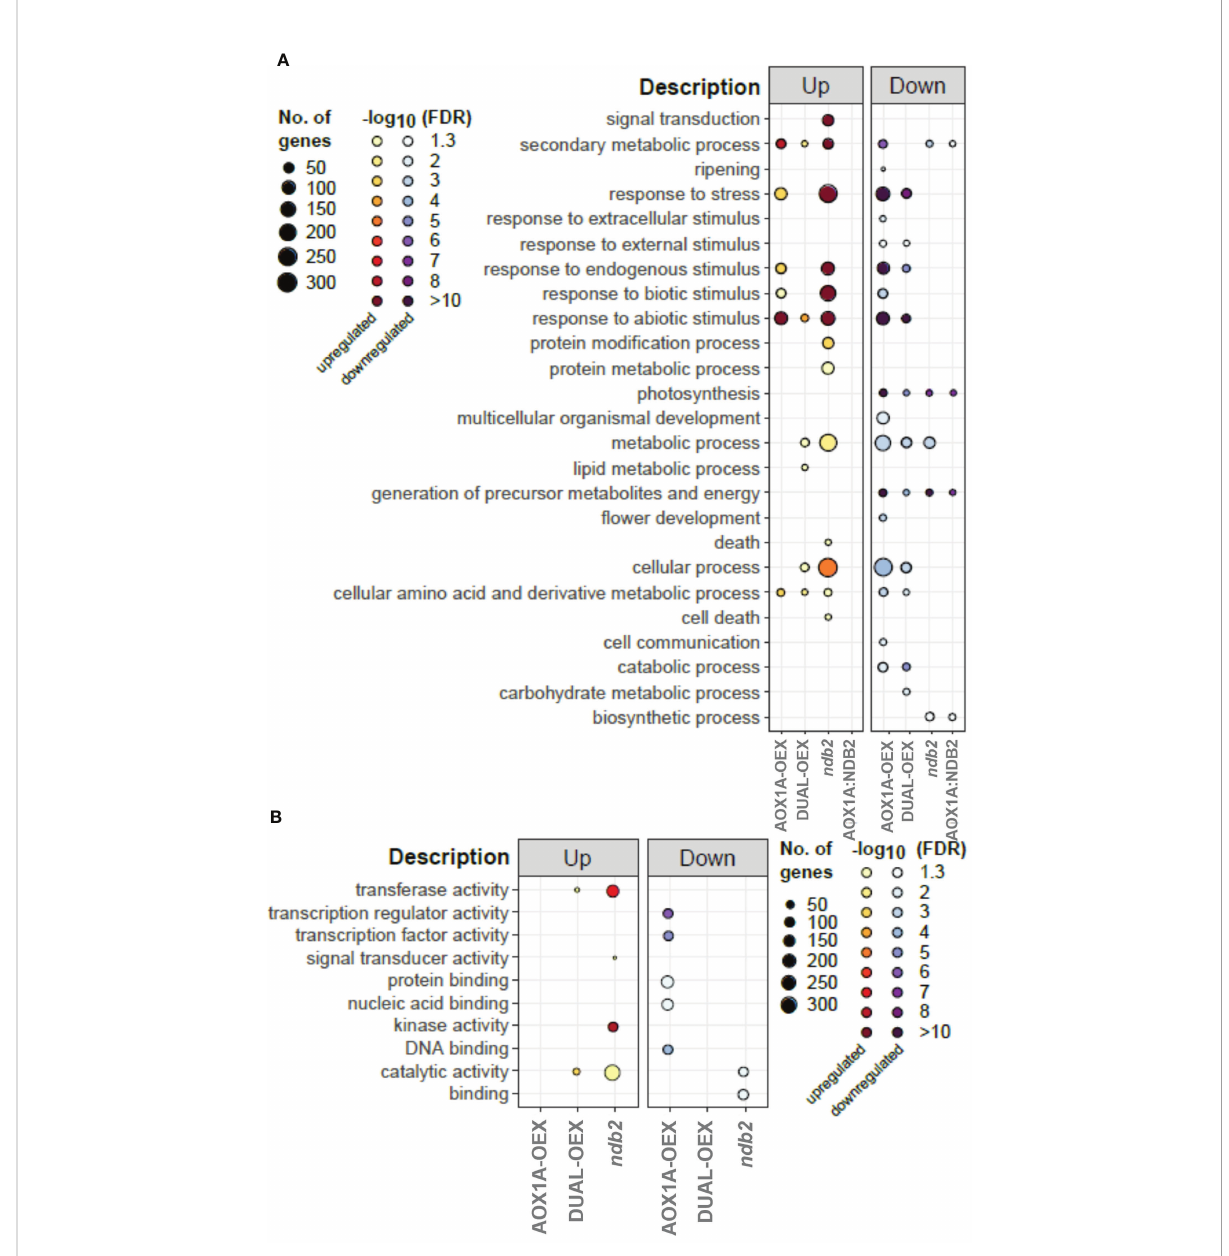
FIGURE 3 Enrichment of gene ontology terms between lines. BinGO was used to pro fi le the enrichment of GO SLIM terms of individual lines, relative to wild type. The set of DEGs that are potentially regulated by AOX1A:NDB2 were also pro fi led separately, relative to wild type. Larger data points represent a larger number of genes within that category, while greater colour intensity represents greater signi fi cance (-log 10 FDR). (A) biological processes, (B) molecular